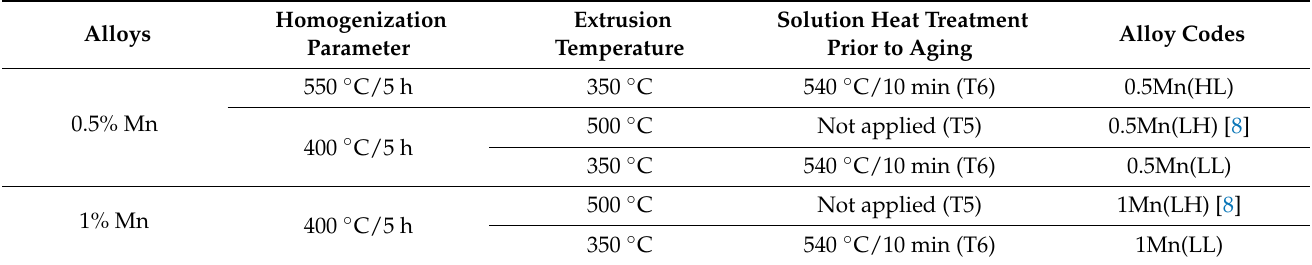
Table 1. Heat treatments applied to the two